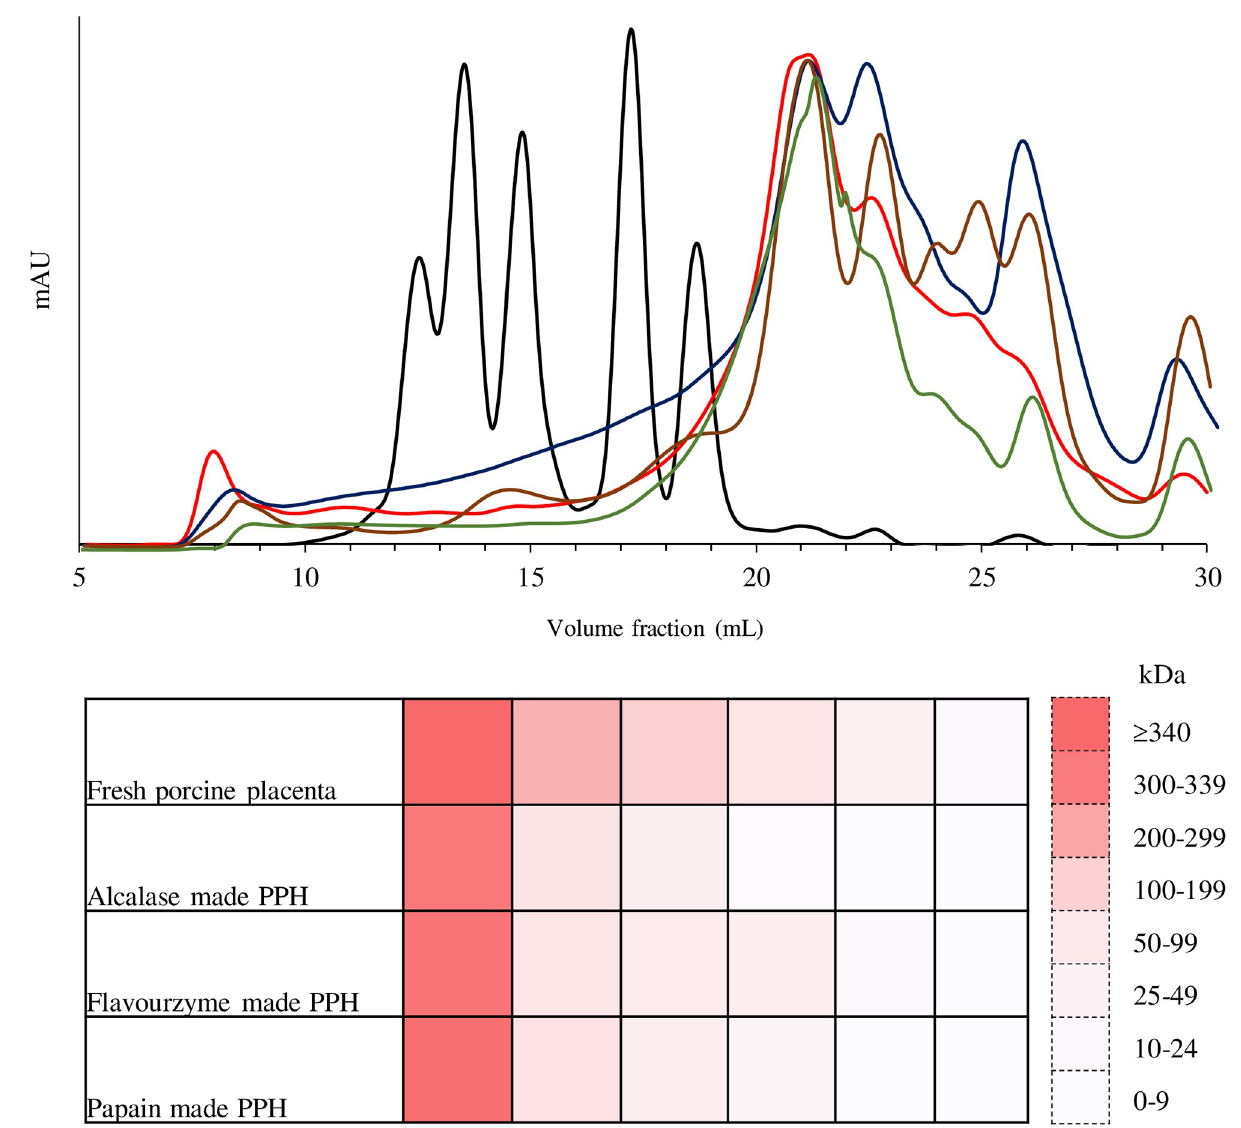
Fig 5. Molecular weight distribution of fresh porcine placenta (brown line) and porcine placenta hydrolysate (PPH) produced by Alcalase (red line), Flavourzyme (blue line), and papain (green line) at 10% enzyme load for 20 min. Standard protein markers are represented by the black peaks.